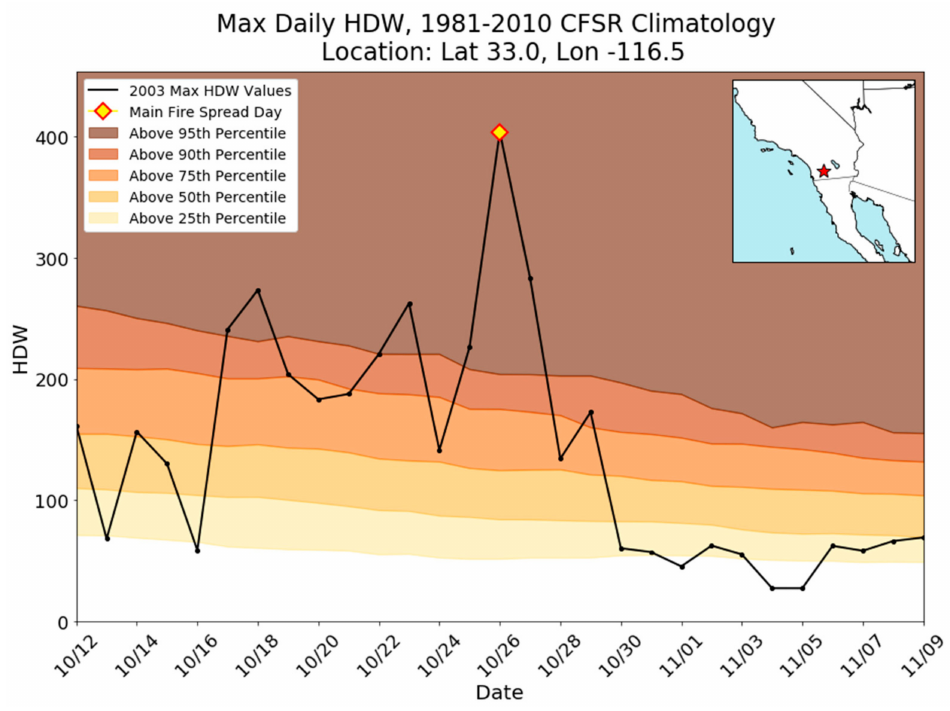
Figure 7. As in Figure 4, but for the Cedar Fire (grid point 33.0 ◦ N, 116.5 ◦ W; 29-day period centered on 26 October). The black trace represents HDW values calculated from CFSR for the same 29-day period in